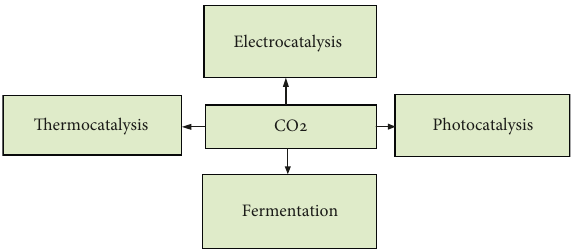
Figure 1: The most effective methods of CO